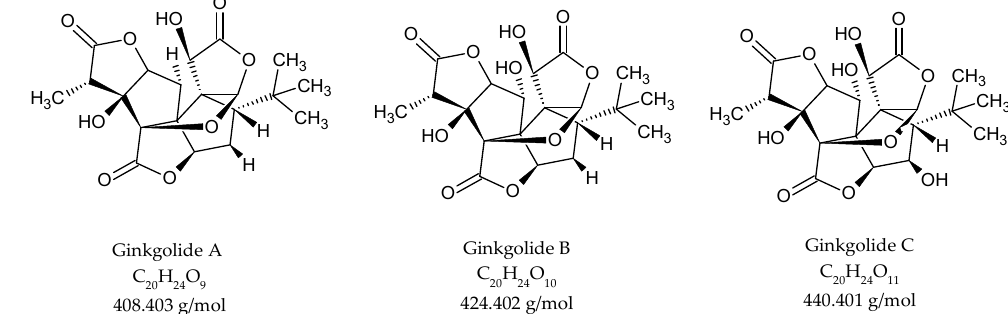
Figure 2. Structures of terpene trilactones quantified in G. biloba bud and leaf extracts.